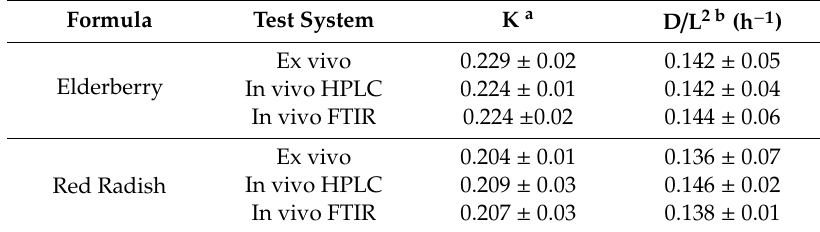
Table 3. Di ff usivity and partition parameters obtained after application of elderberry and red radish lipsticks to the SC either in vivo human volunteers or ex vivo on porcine ear skin. All values are the mean ± standard deviation ( n = 9). Statistical significance denoted by (*) ( p ≤ 0.05), determined by two-way ANOVA.